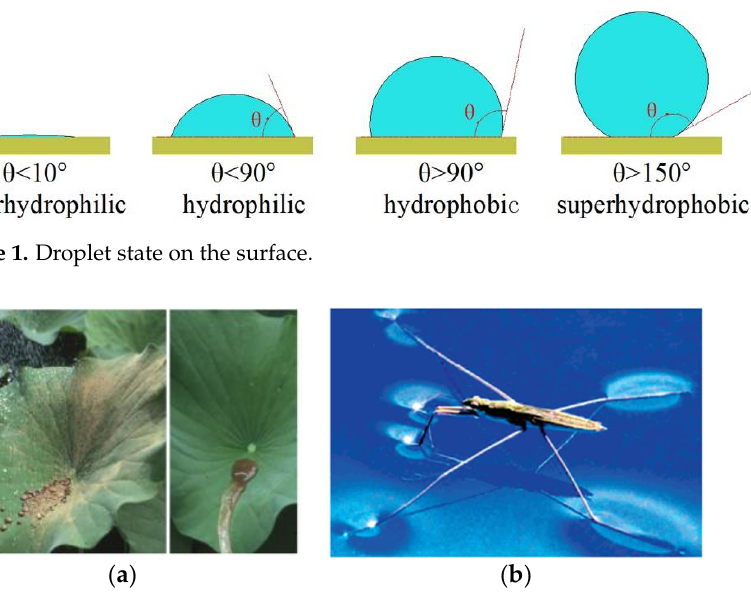
Figure 2. Superhydrophobic surface. ( a ) Lotus leaf. Reprinted with permission from Ref [43]. Copyright 2015 Elsevier. ( b ) Water strider. Reprinted with permission from Ref [3]. Copyright 2007 American Chemical Society.